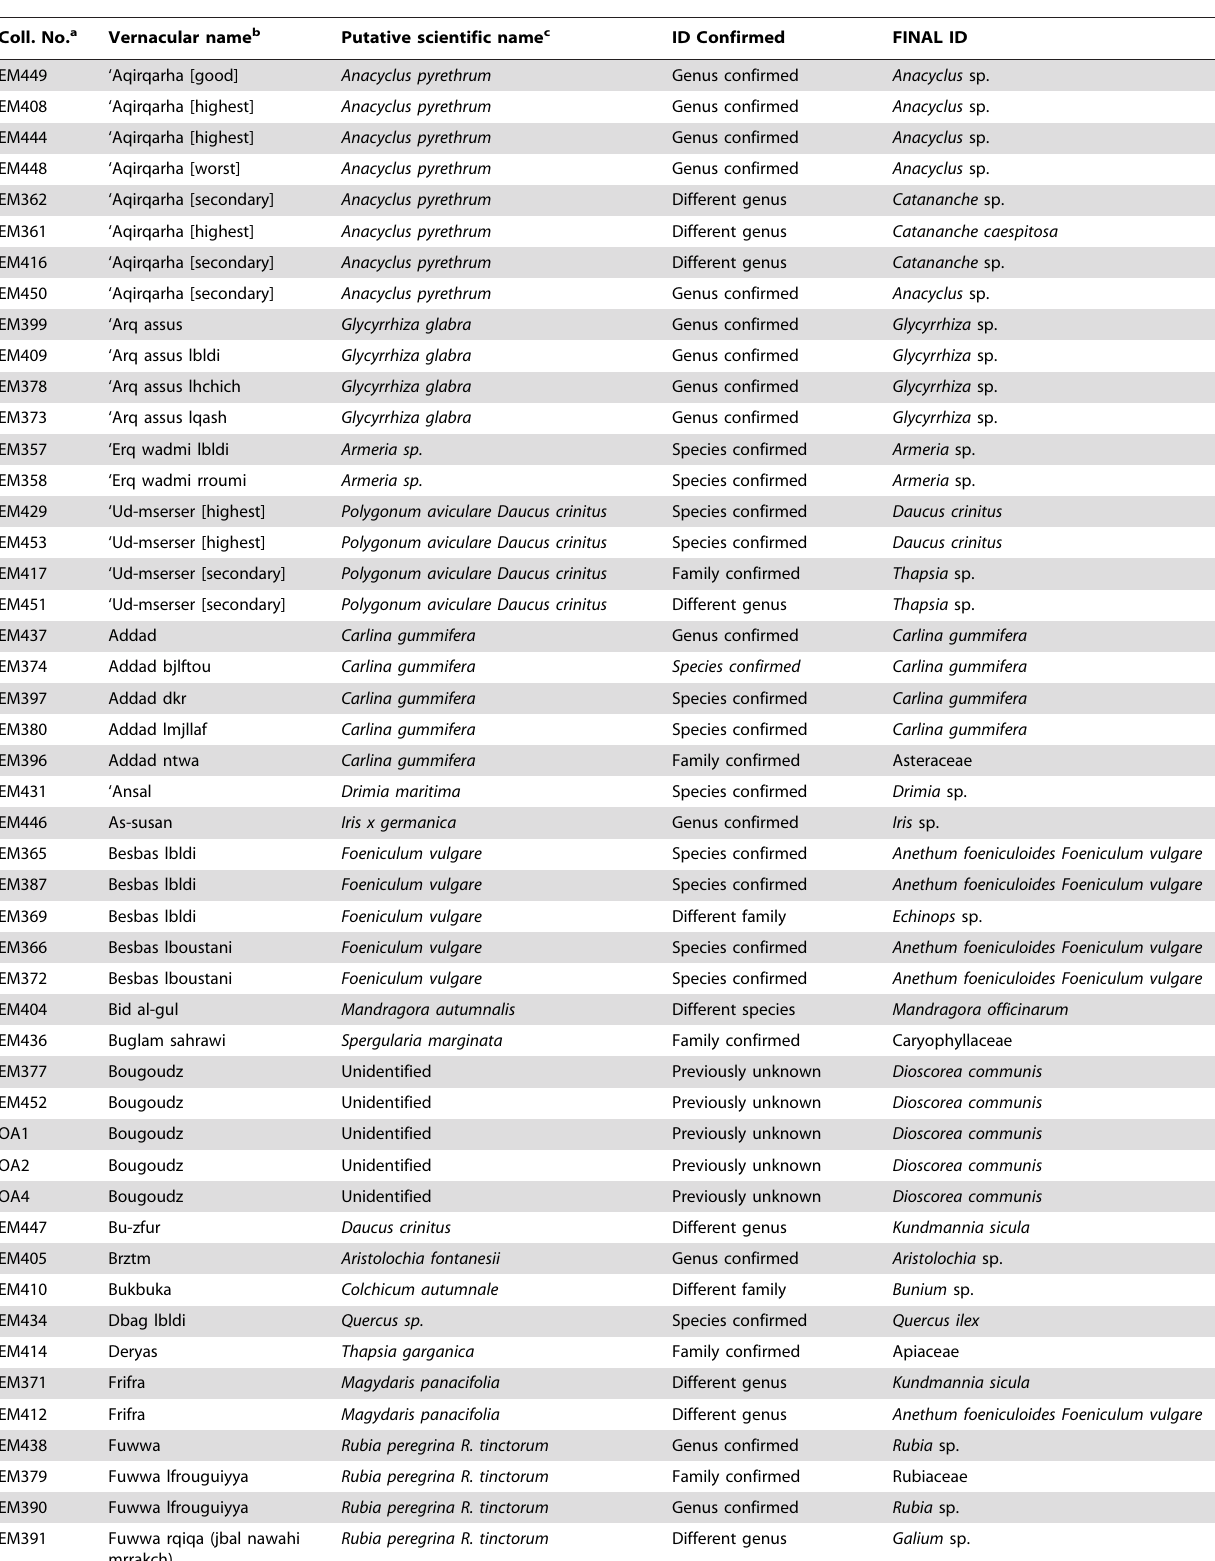
Table 2. Barcoding identifications and GenBank accession numbers in order of transcribed Arab product name.